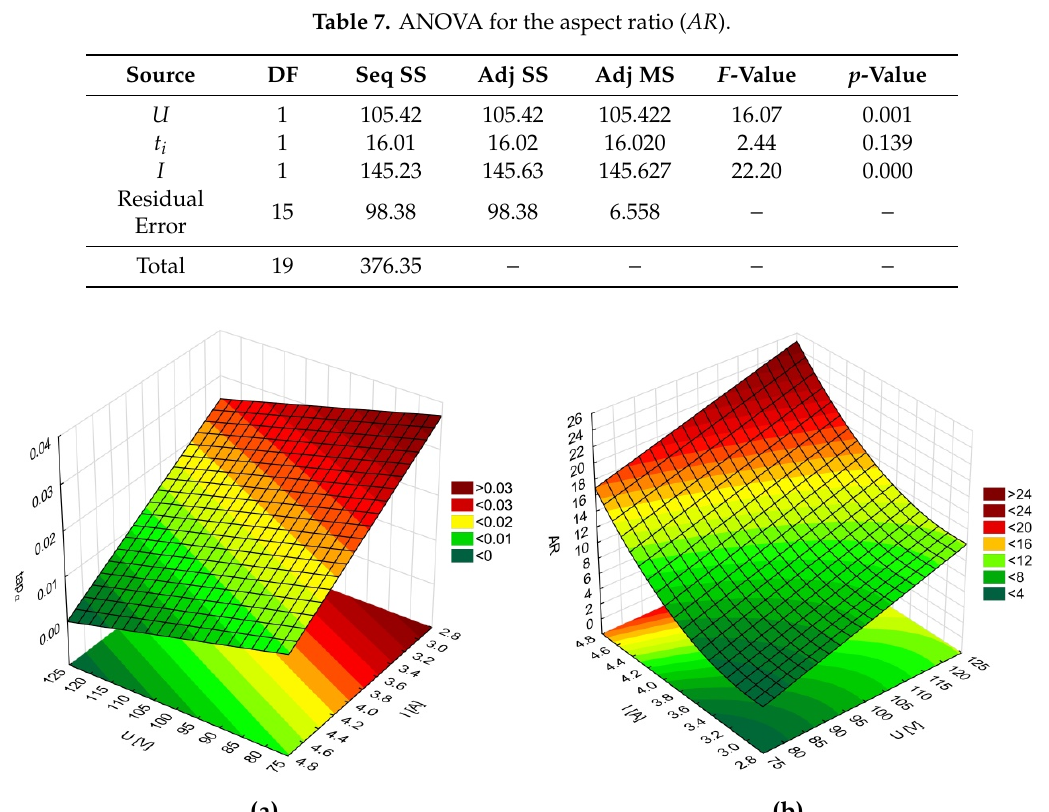
(Figure 8). In the case where deionized water was applied as a working fluid, the electrical discharges were accompanied by electrochemical dissolution. Deionized water can be treated as a dielectric fluid and a weak electrolyte that contributes to material removal by the simultaneous interaction of electrochemical dissolution and electrical discharges in single discharge [33]. The analysis of the voltage and current waveforms of a single discharge showed that the time duration of the electrical discharge constituted approximately 50–60% the entire single pulse time (regardless of the time duration applied to the pulse). For this reason, a higher value of pulse time t i = 999 µ s ( U = 100 V, I = 3.83 A) extended the time during which electrical discharges and abnormal discharges occurred. However, a higher value of applied current amplitude caused a larger amount of material to be removed, which resulted in a higher accumulation of debris. Figures 9 and 10 show the obtained hole shapes for extreme values of applied t i . In the case where the pulse time was extended, the average bottom diameter was higher and the taper angle was decreased. The dimensional accuracy of the hole was improved in comparison to the case where a shorter pulse time was